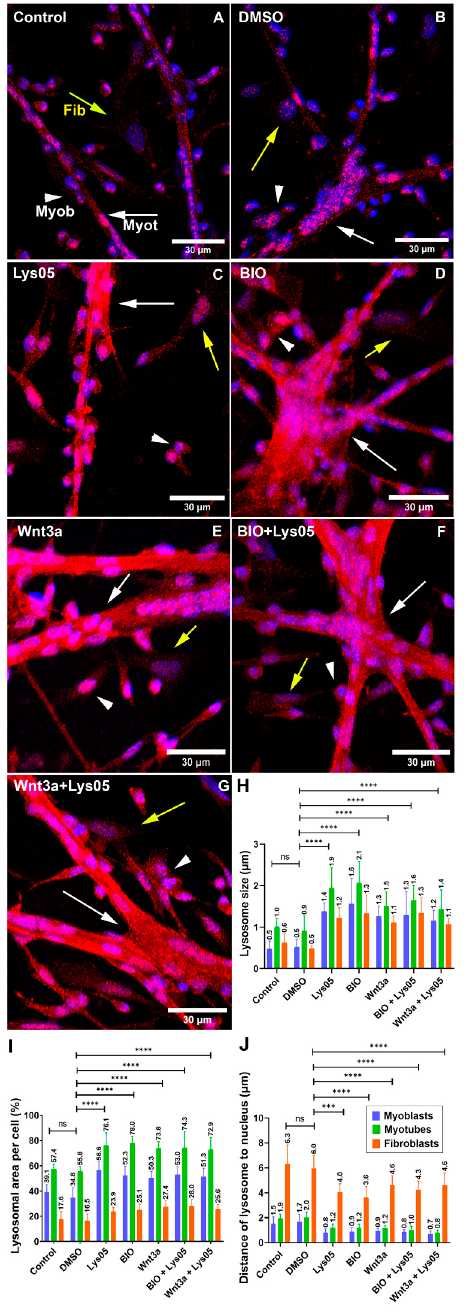
Figure 4. Activation of the Wnt/beta-catenin pathway increases the lysosomal compartment in chick muscle cells. Chick myogenic cells were grown for 24 h and treated with Lys05, BIO,